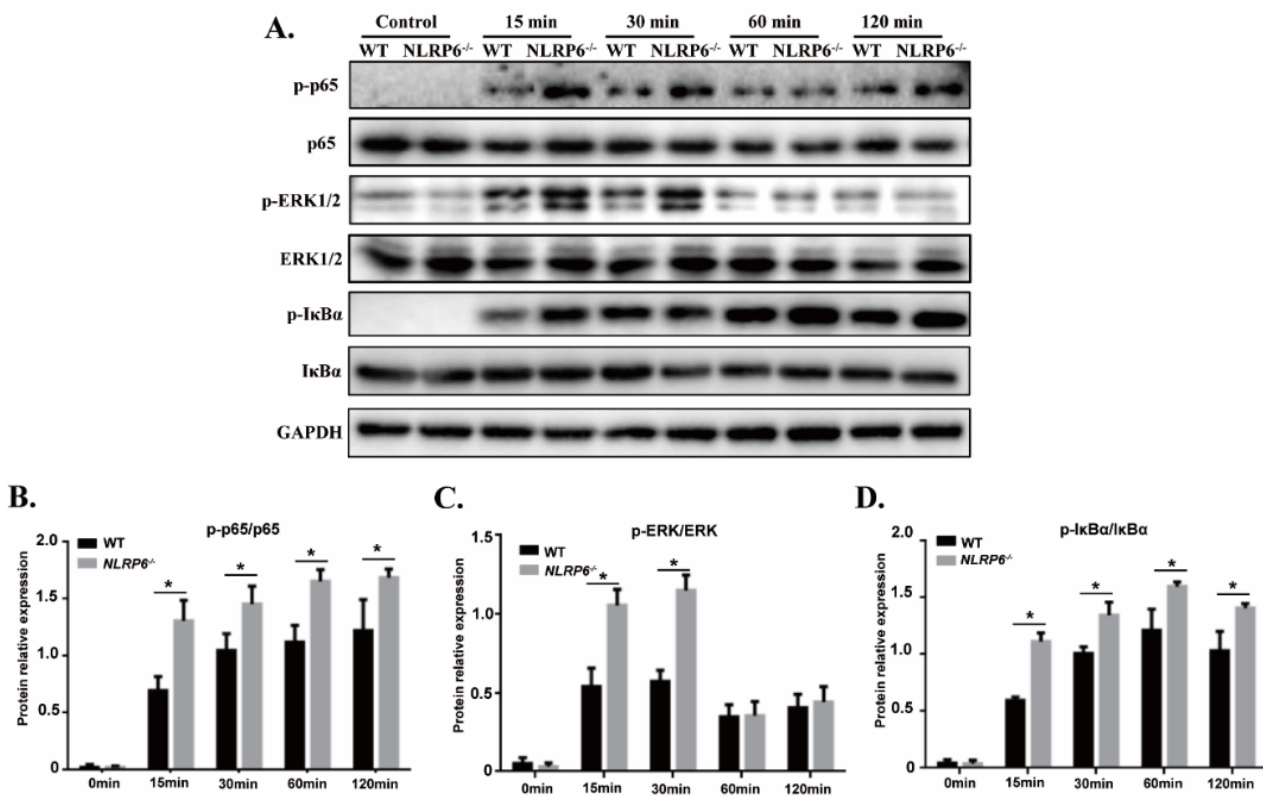
Figure 4. NLRP6 inhibits activation of NF- κ B and ERK signal pathways in S. pneumoniae -infected macrophages. Macrophages from WT and NLRP6 − / − were infected with S. pneumoniae at an MOI of 1 for 0, 15, 30, 60, and 120 min. ( A ) p-p65, pERK, pI κ B α , p65, ERK, and I κ B α protein expression was determined by western blot. Ratio of p-p65 ( B ), pERK ( C ), and pI κ B α ( D ) levels against p65, ERK, and I κ B α levels was quantified. Statistical significance was determined by Student’s t -test. (* p < 0.05).